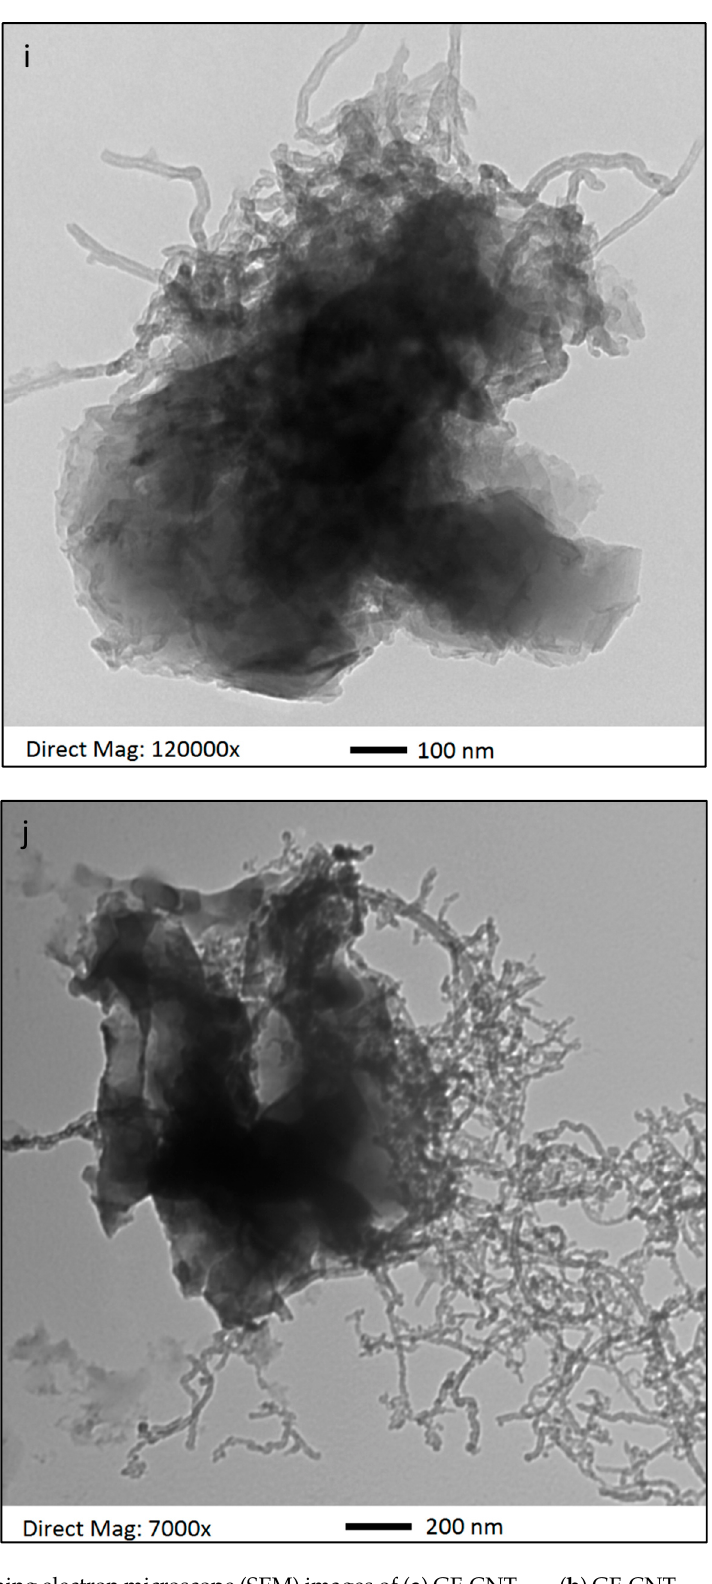
Figure 3. Scanning electron microscope (SEM) images of ( a ) GF-CNT 23.2 , ( b ) GF-CNT 19.8 , ( c ) GF-CNT 16 , ( d ) SMZ-CNT 23.2 , ( e ) SMZ-CNT 19.8 , ( f ) SMZ-CNT 16 , ( g ) pure GF, ( h ) pure SMZ, and Transmission electron microscopy (TEM) images of ( i ) GF-CNT 16 , ( j ) SMZ-CNT 16 .